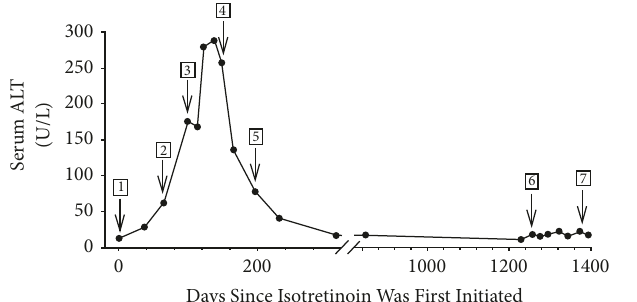
Figure 1: Serum alanine aminotransferase levels (ALT) over time. The numbered arrows represent 1. initiation of oral isotretinoin at 30 mg twice a day; 2. increase in the dose to 40 mg twice a day; 3. discontinuation of isotretinoin; 4. initiation of oral cholestyramine powder 4 g a day with breakfast; 5. discontinuation of cholestyramine; 6. reinstitution of oral isotretinoin at 30 mg twice a day; 7. discontinuation of